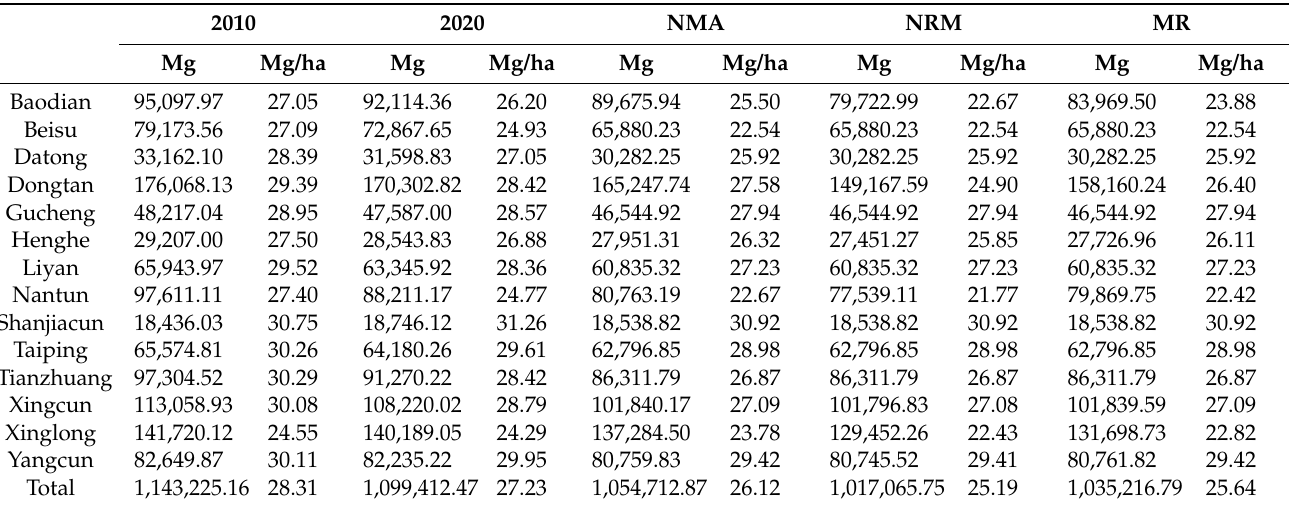
Table 5. Total carbon storage and density of each mine in different